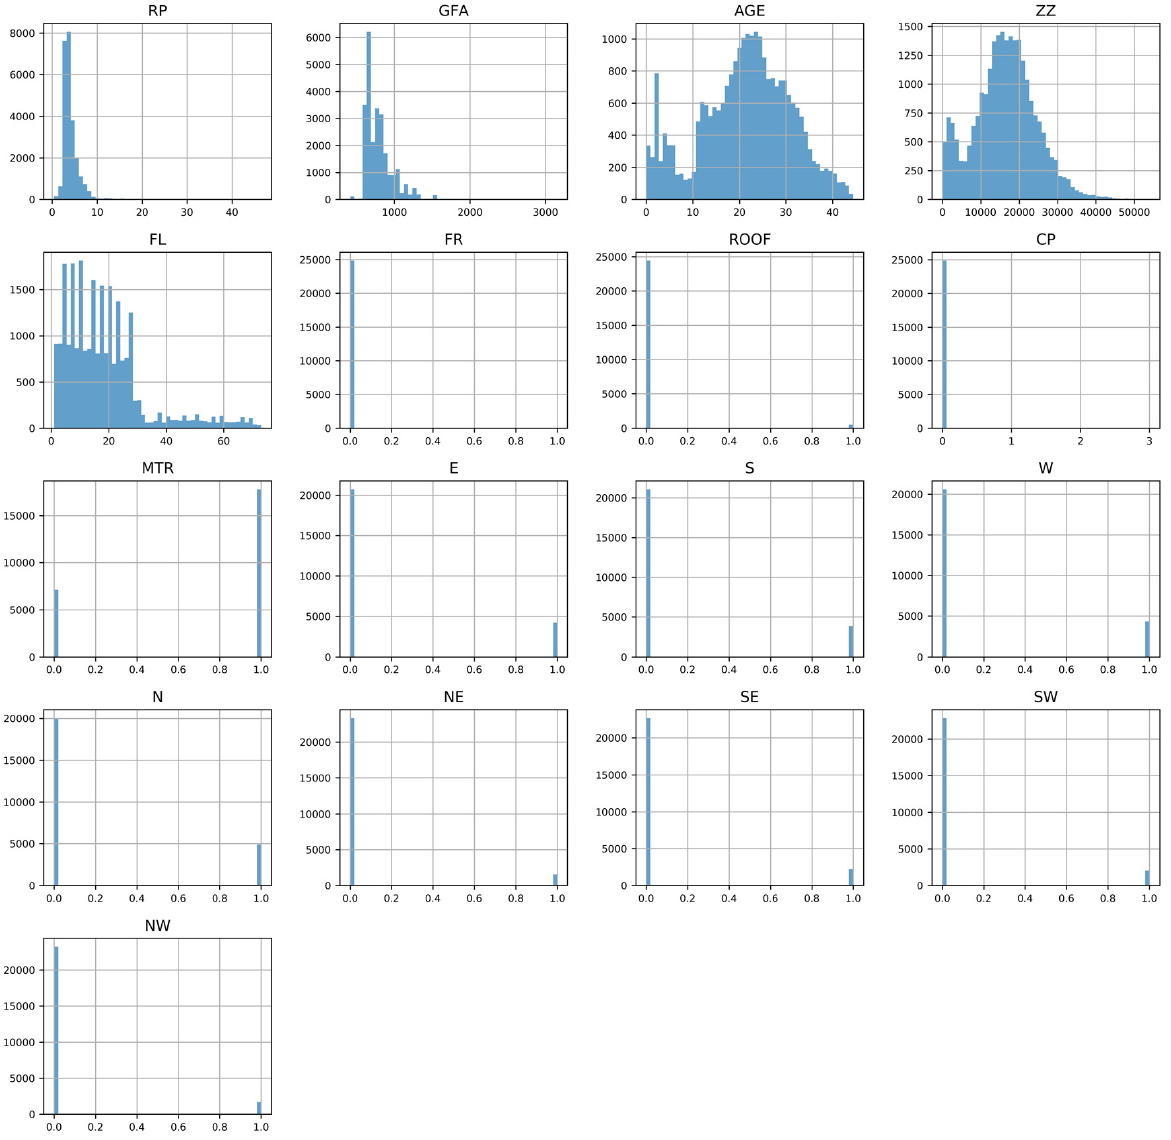
Figure 1. Figure 1. Histogram.